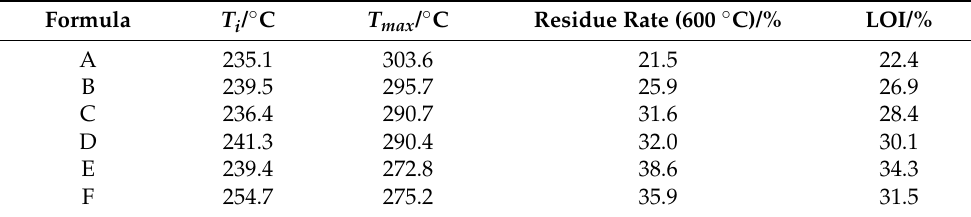
Figure 8. Thermal decomposition gas phase infrared spectrum of HPN-EPPA-UR-PA resin (For- mula D) at different temperatures, a: 200 °C; b: 260 °C; c: 300 °C ( 𝑇 (cid:3040)(cid:3028)(cid:3051) ); d: 500 °C. Table 2. Decomposition temperature and carbon residue of HPN-EPPA-UR-PA resin.